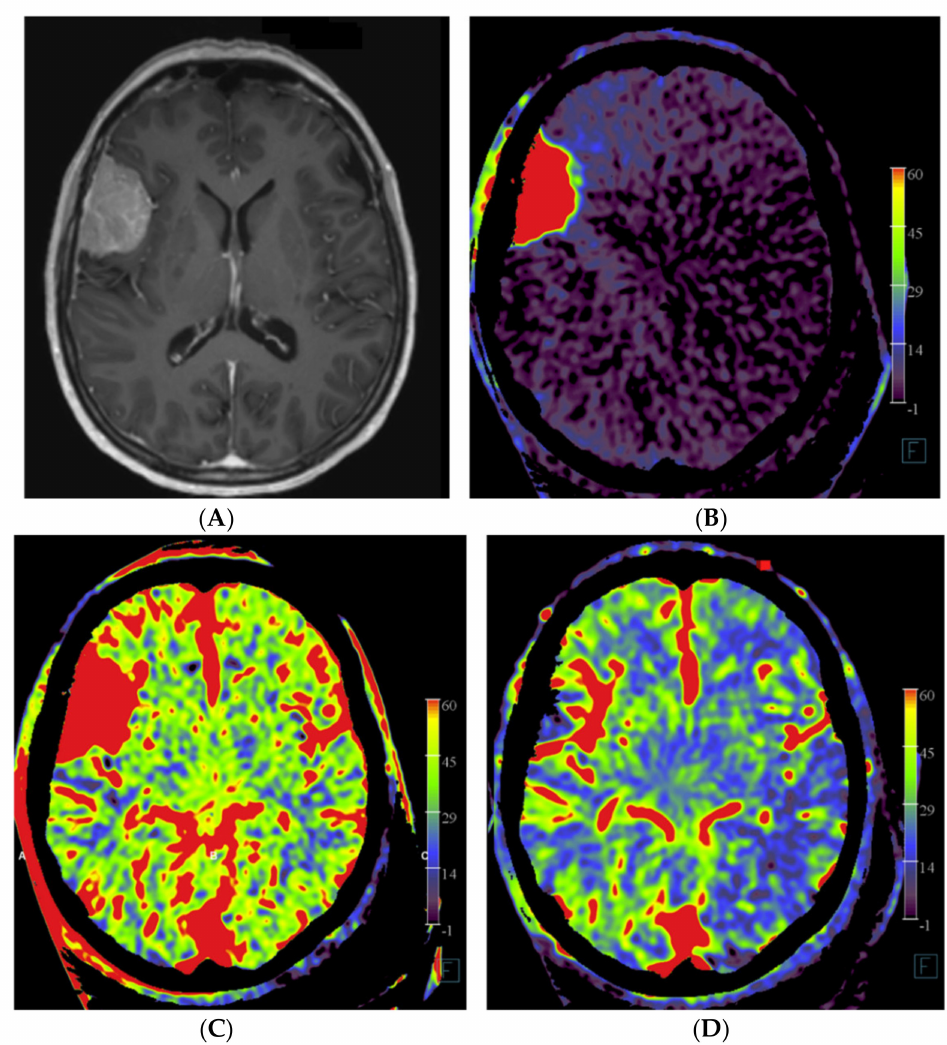
Figure 2. Imaging of a patient with a right-sided perisylvian meningioma. ( A ) Axial post-contrast T1- weighted MRI image of patient no. 4 shows the presence of an enhancing, extra-axially located tumor in the right perisylvian area. ( B ) Pre-embolization axial PBV reformation obtained after selective right external carotid artery injection and ( C ) after aortic root contrast injection shows a hypervascular tumor. In consultation with the operating neurosurgeon, a pre-operative embolization was performed. ( D ) Post-embolization axial reformation of whole brain PBV scan shows devascularization of the portion supplied by the dural